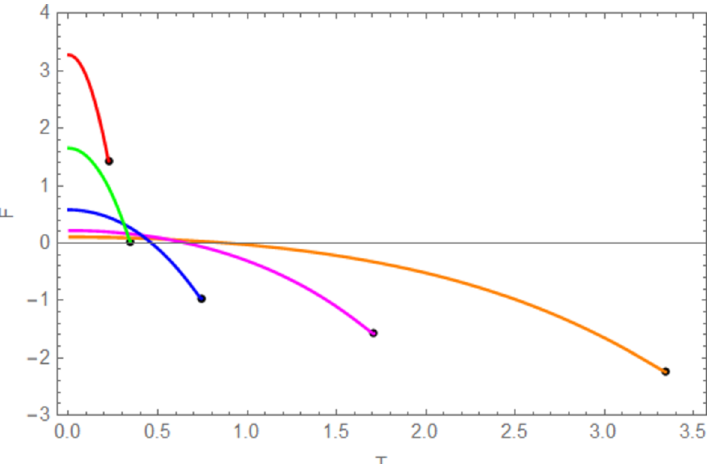
Figure 2 . The (cid:12)gure displays free energy F of the thermalon con(cid:12)guration as a function of the temperature T = (cid:12) (cid:0) 1 for several values of the coupling (cid:21) . We have used L = 1 and (cid:12)xed electircal + p potential (cid:8) (cid:17) (cid:8) 2 + (cid:8) 2 = 0 : 15. From right to left: (cid:21) = 0 : 05 (orange), (cid:21) = 0 : 10 (pink), (cid:21) = 0 : 25 A B (blue), (cid:21) = 0 : 65 (green) and (cid:21) = 1 : 20 (red). The black dots at the end of each plots represent the maximum temperature of the thermalon. All curves correspond to a physical solution (cid:5) + = (cid:5) (cid:0) due to the junction condition of